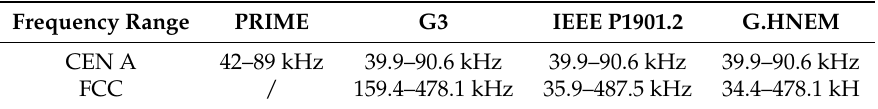
Table 1. Frequency bands applied in four Narrowband PLC standards in Europe and